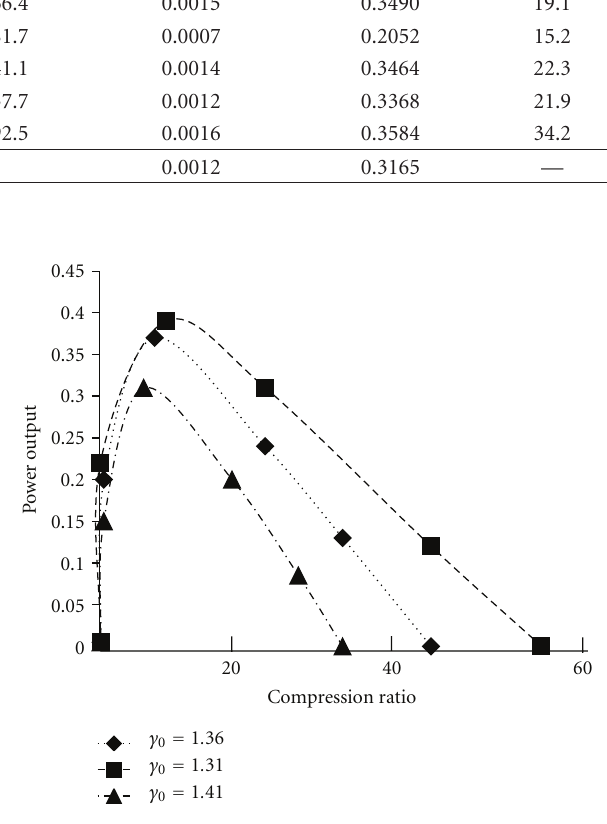
Figure 5: Comparison of performance of SPFA-GA, L-FFA, I-PSO, BA, ABC, and MSB-ABC in e ffi ciency analyzing of the Atkinson cycle.